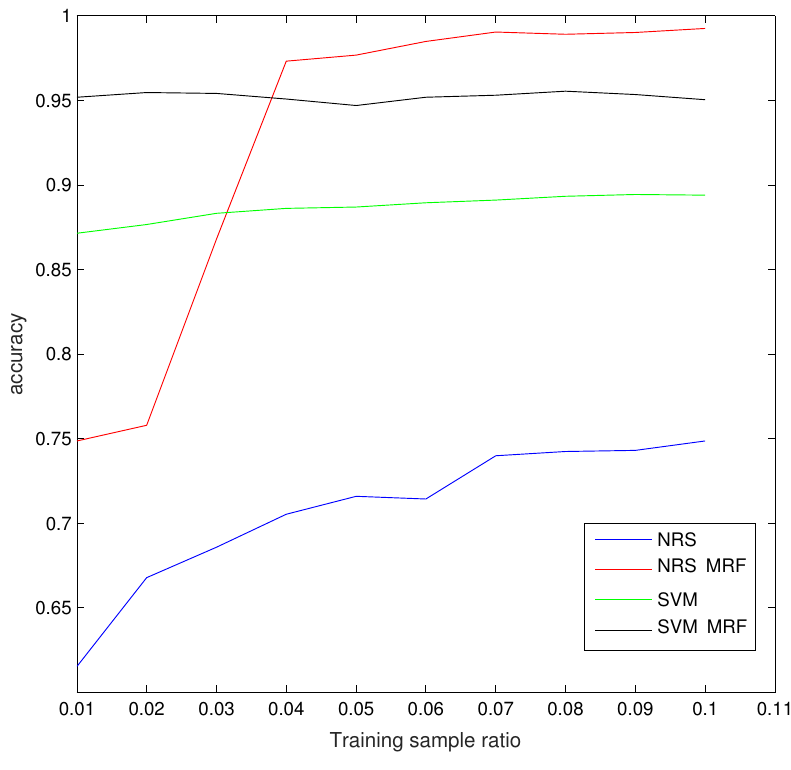
Figure 8. The influence of the training sample ratio on classification accuracy for Flevoland I